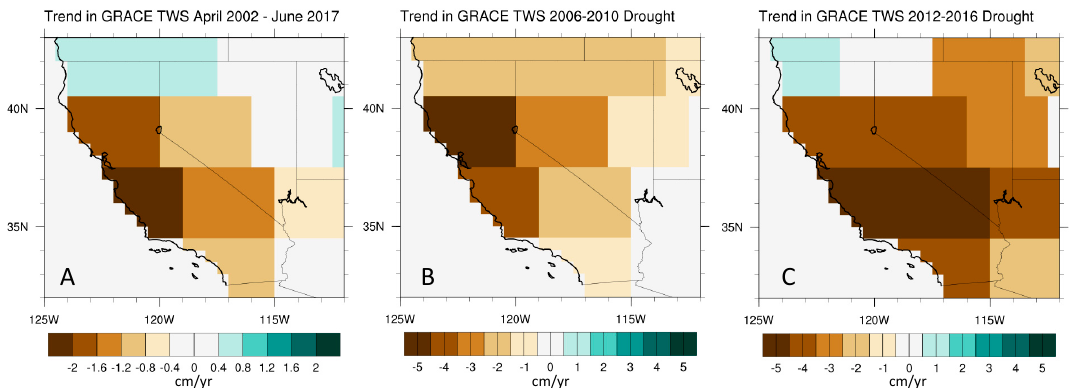
Figure 1. Trends in TWS observed by the GRACE satellites for ( A ) the entire time period of the study, ( B ) the drought period from 2006 to 2010, and ( C ) the drought period from 2012 to 2016.